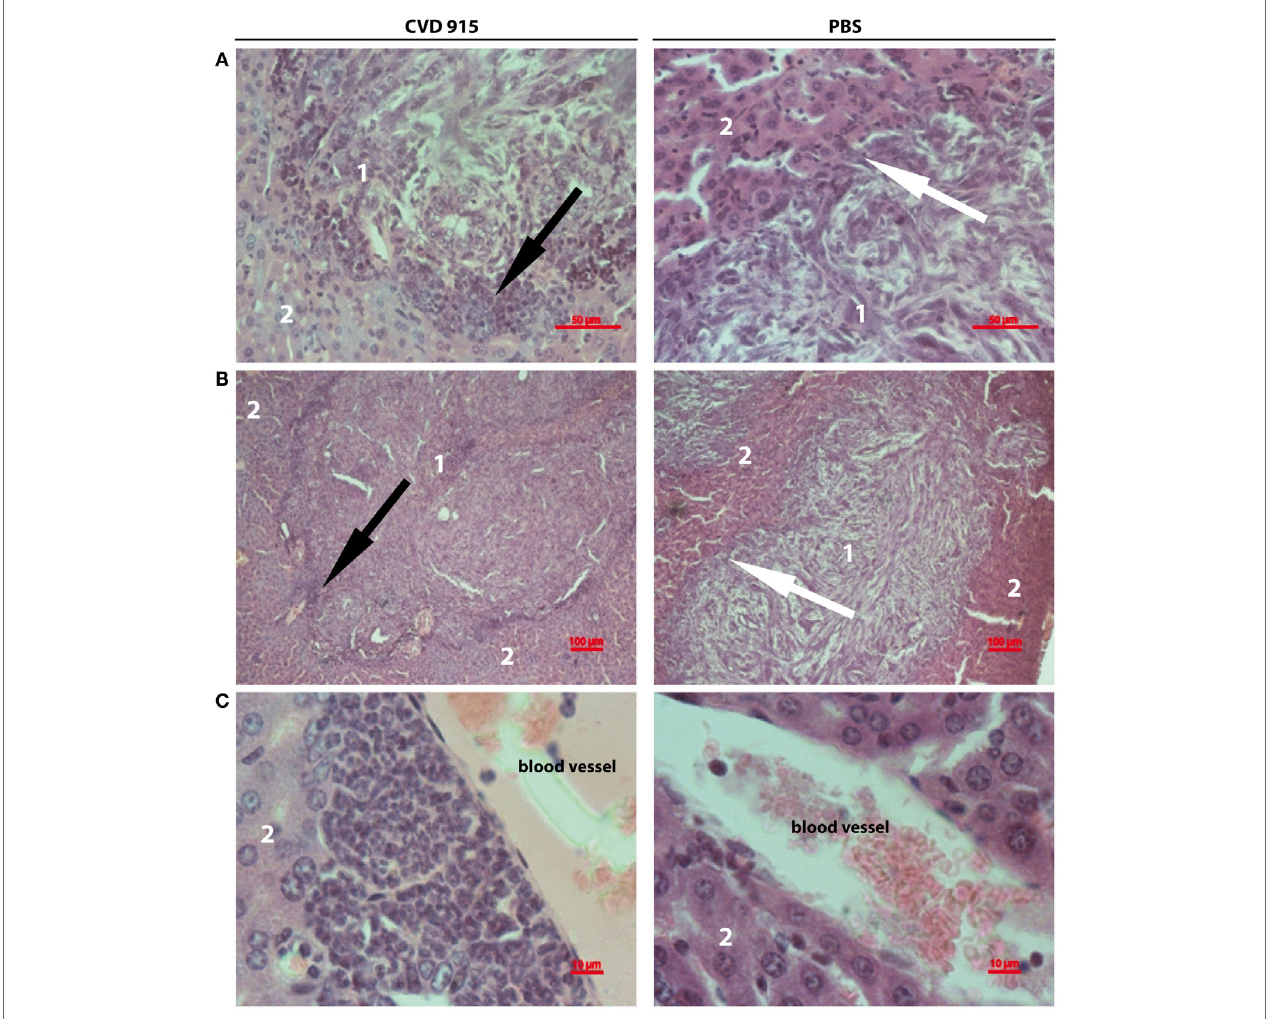
FigUre 6 | liver-infiltrating inflammatory cells after oral Salmonella- based treatment . Twenty-one days after treatment, livers were removed from tumor-bearing mice. Images showing representative H&E stained liver sections from CVD 915- (left panels) or PBS-treated (right panels) animals. (a,B) Image of a metastatic focus in the liver. (a) Original magnification 400 × . (B) Original magnification 100 × . (c) Left: image of perivascular infiltrating leukocytes. Right: absence of perivascular infiltrate (original magnification 1000 × ). (a–c) Images shown are from one liver representative of five animals per group. (1) tumor nodule, (2) hepatic tissue, black arrows indicate leukocyte infiltration around a metastatic nodule, white arrows indicate the absence of leukocyte infiltration around a metastatic